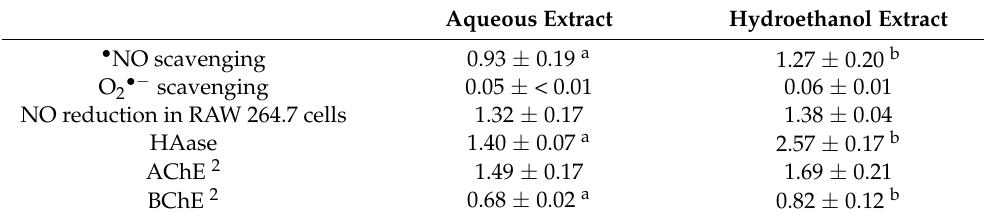
Figure 2. Scavenging effect of camel grass extracts against nitric oxide ( • NO) ( a ) and superoxide anion (O 2 •− ) ( b ) radicals generated in a cell-free system. Results are expressed as percentage of the respective control (mean ± SD of at least three determinations, each performed in triplicate). Table 2. IC 50 values (mg lyophilized extract/mL) obtained for the antioxidant, anti-inflammatory and enzyme inhibitory capacity of camel grass extracts 1